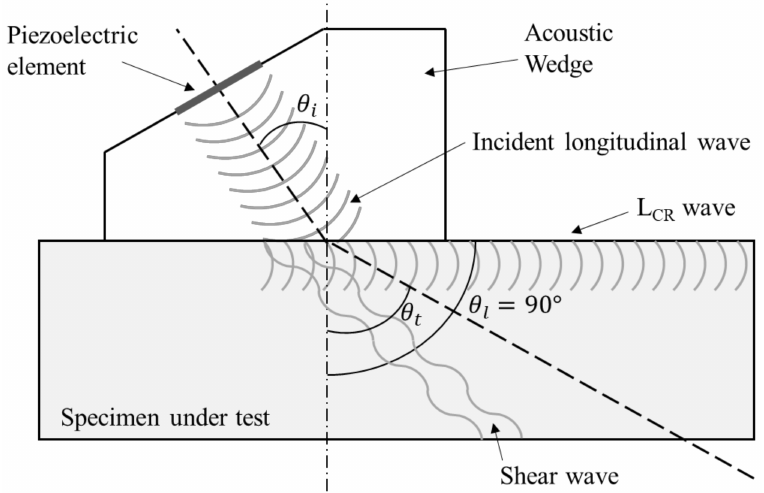
Figure 1. Excitation of the L CR wave through transmitter and wedge